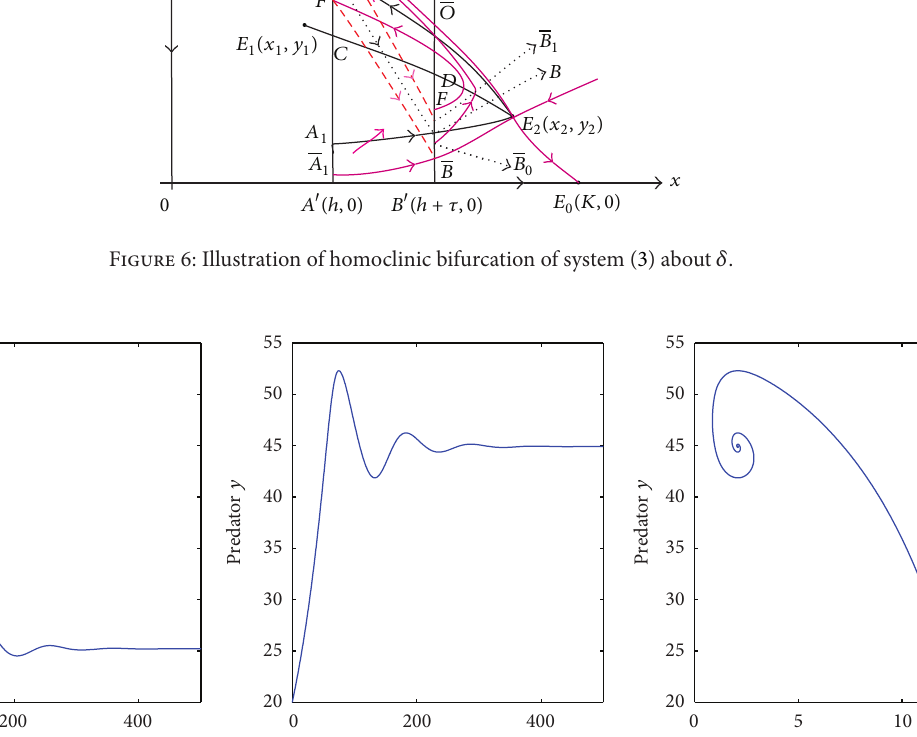
positions. We denote the new intersections of the unstable and stable flow of (𝑥 2 , 𝑦 2 ) and the impulse set 𝑥 = ℎ and phase set 𝑥 = ℎ + 𝜏 are 𝐴 and 𝑂 , and 𝐴 1 and 𝐵 , respectively (see Figure 6). According to Theorem 19, we have (1−𝛽 ∗ )𝑦 𝐴 = 𝑦 𝐵